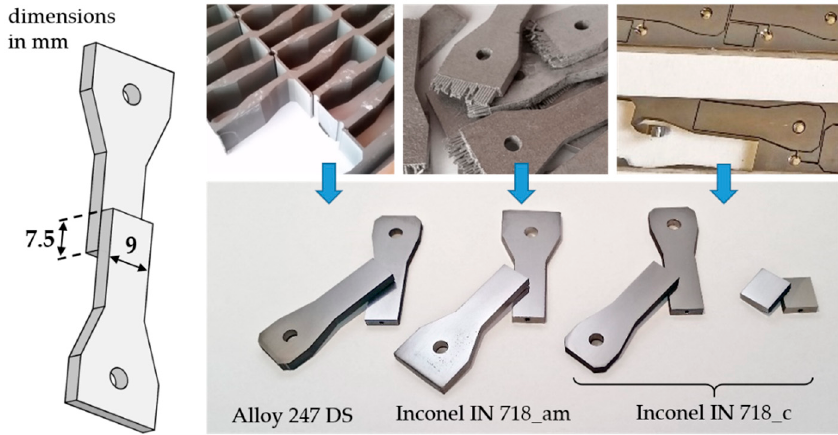
Figure 2. Sample geometry and base materials. Thickness of all samples: 3 mm.